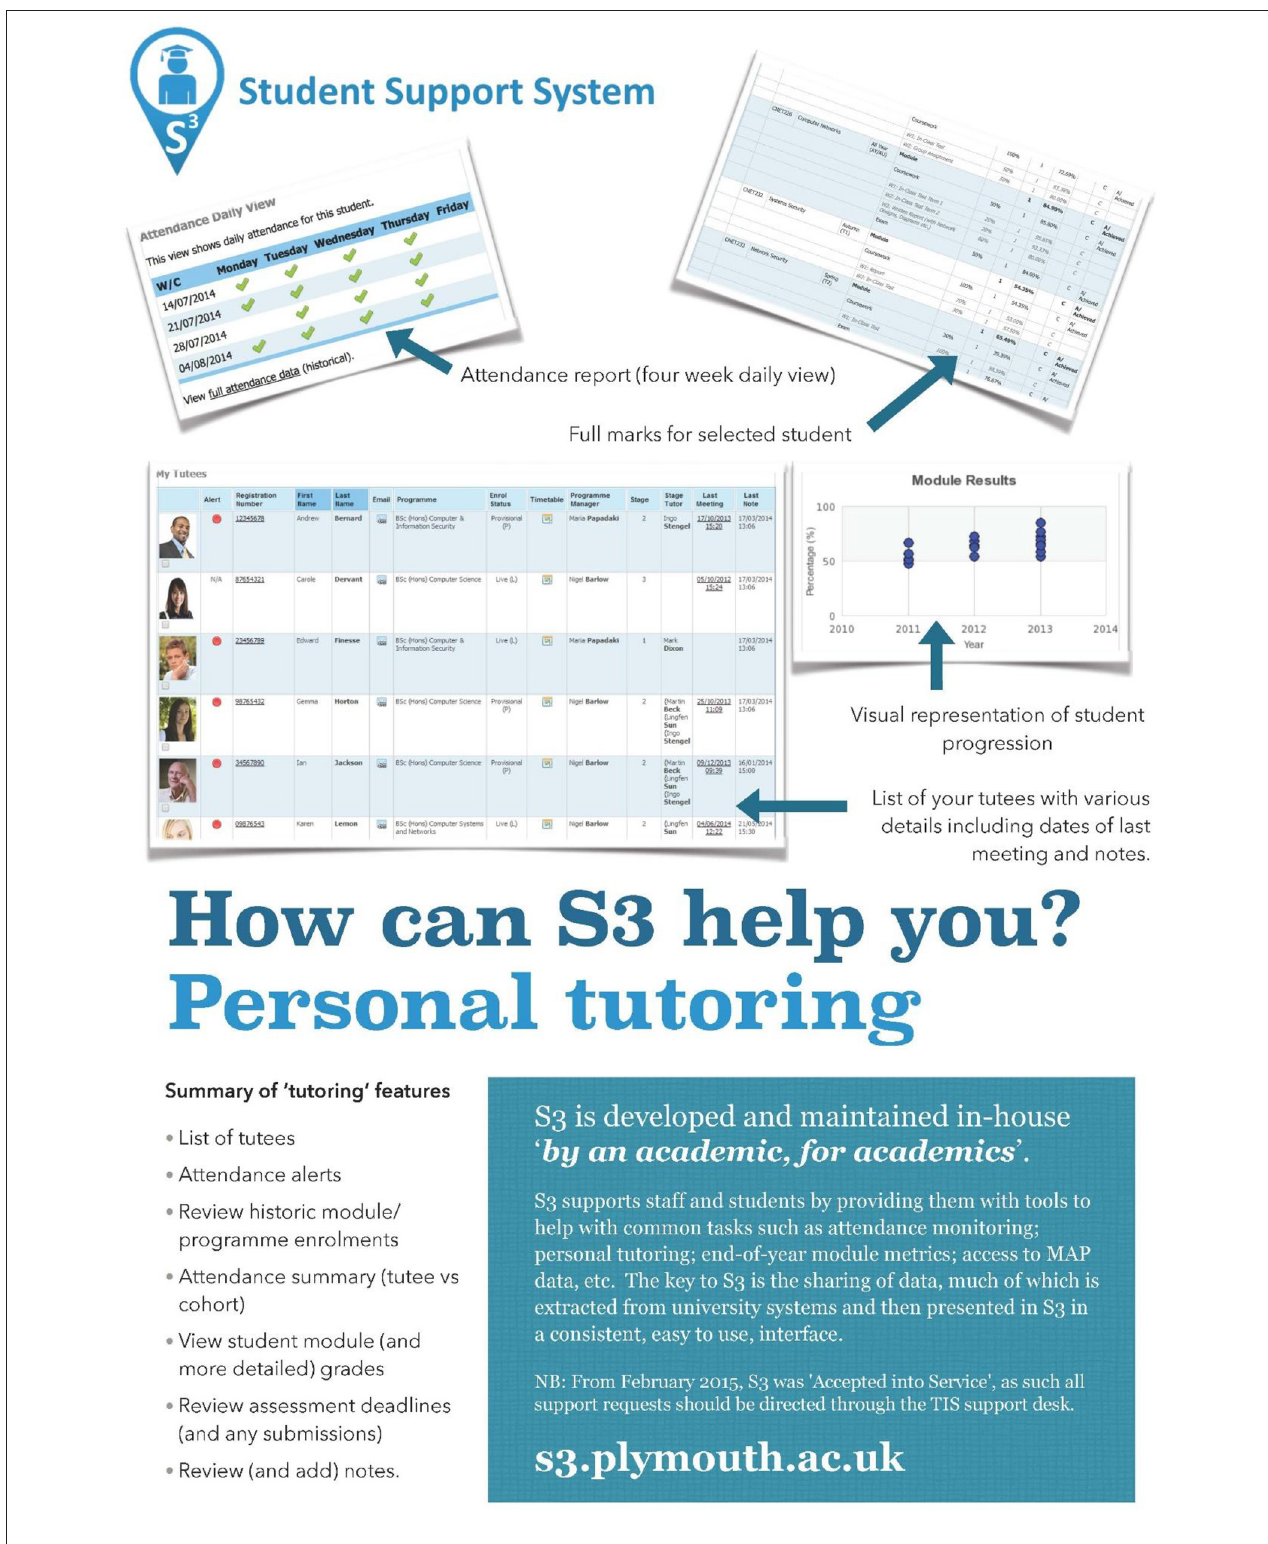
FIGURE A2 | How can S3 help you? Personal